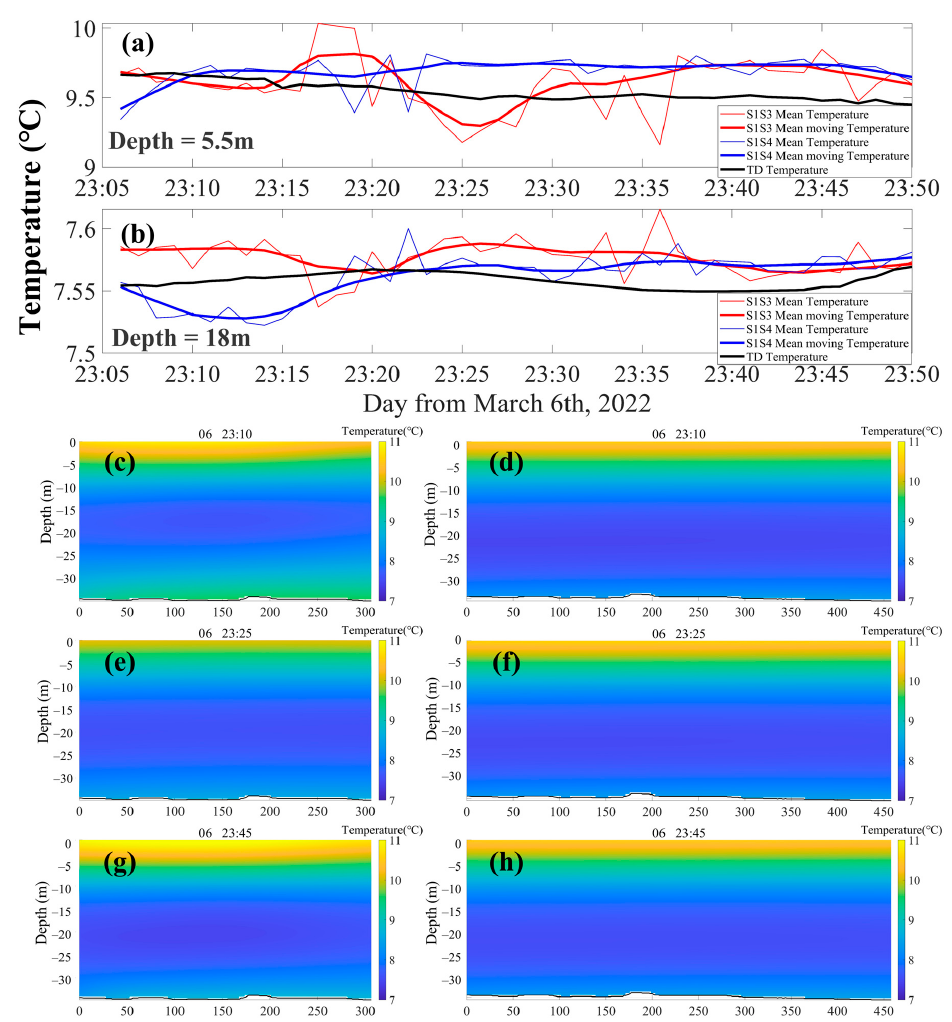
Figure 8. Layer-averaged water temperature comparison of S1 to S3: ( a ) shows the temperature inversion results by initial travel time at three layers; ( b ) shows the temperature inversion results by corrected travel time at three layers.